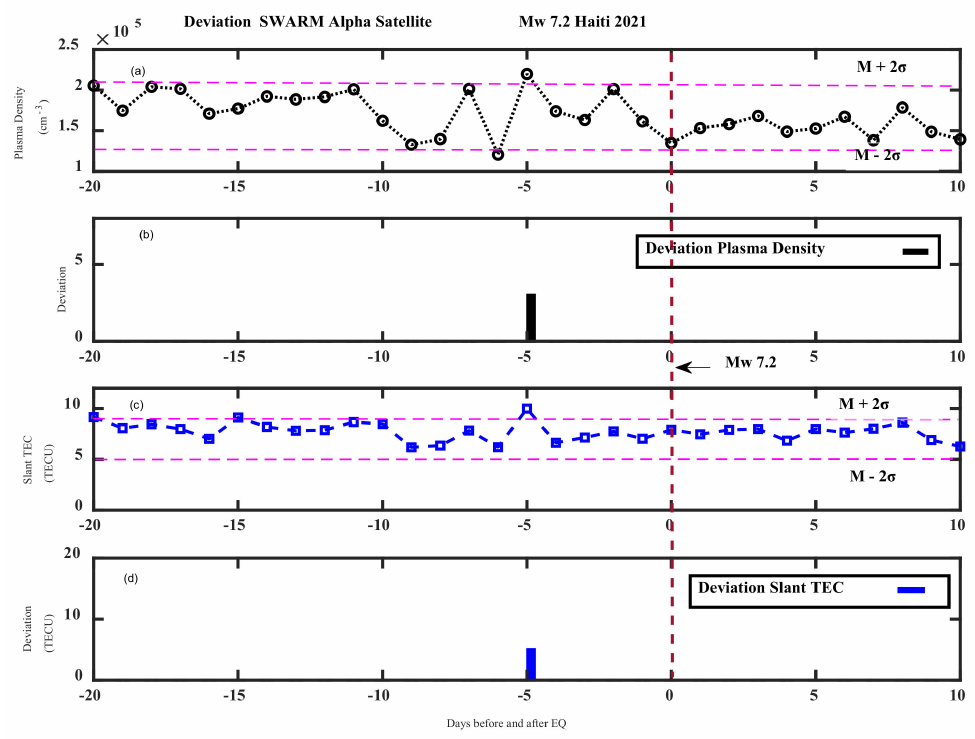
Figure 7. ( a ) plasma density, ( b ) deviation of plasma density as an anomaly, ( c ) STEC, and ( d ) devi- ation of STEC from upper and lower bounds of mean and standard deviation as an anomaly from Swarm-A over M w 7.2 (Haiti). The red dashed line represents the EQ